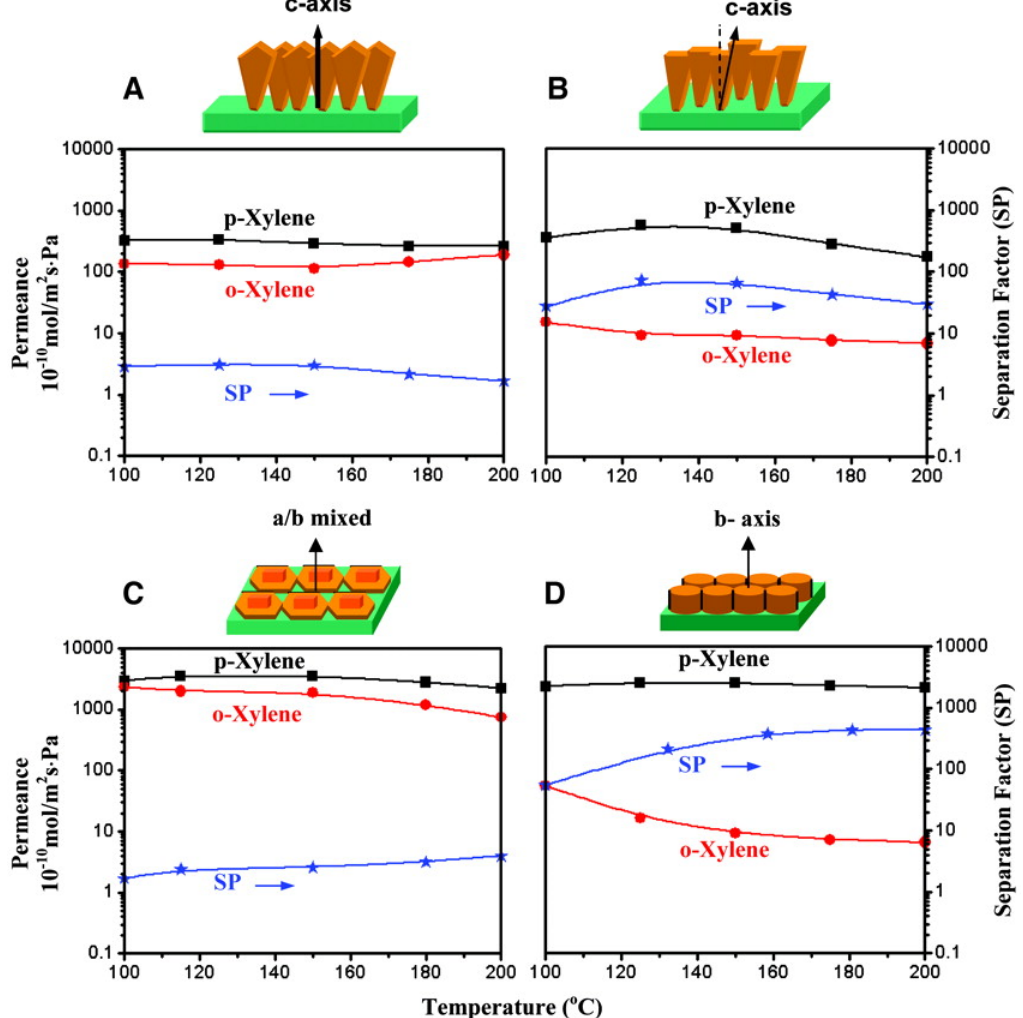
Figure 7. ZSM-5 membrane performance in xylene isomer separation (feed partial pressure of p -xylene and o -xylene are 0.45 kPa and 0.35 kPa, respectively): p -xylene, o -xylene permeance, and mixture separation factor (SP) in dependence on temperature for ( A ) c -oriented; ( B ) [h0h]-oriented; ( C ) a - and b -oriented; and ( D ) b -oriented film [226]. Reprinted with permission from